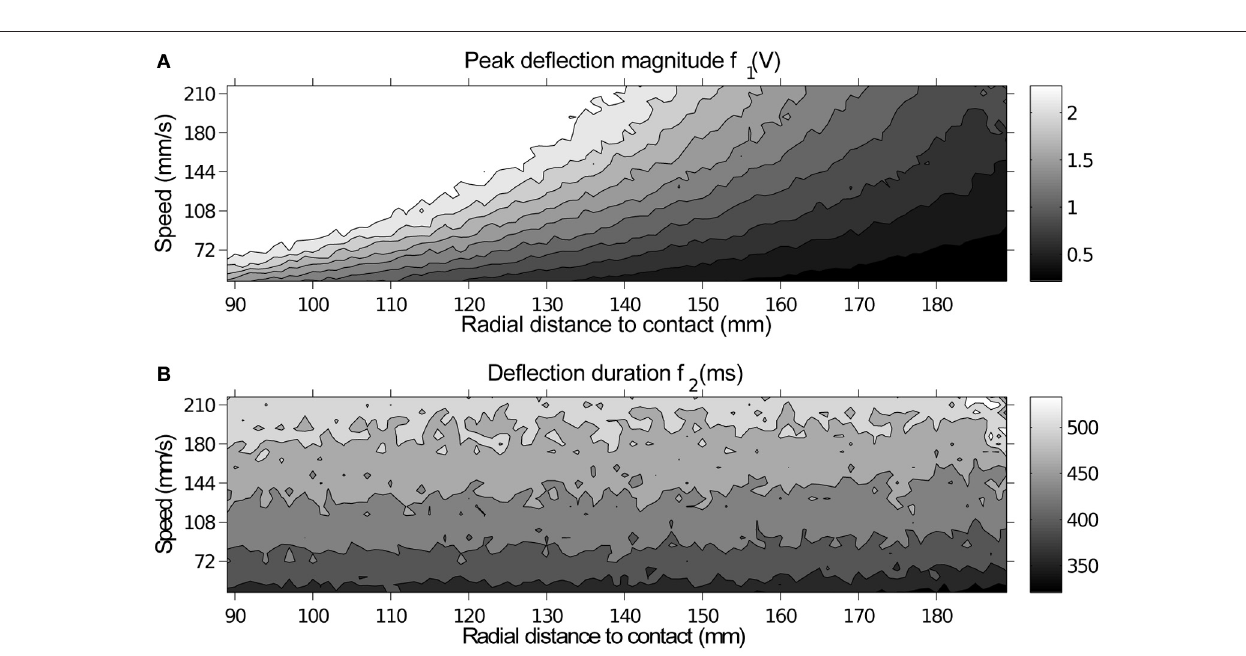
FIGURE 7 | A contour plot of peak deflection magnitude and duration for each contact showing how each feature varies with respect to contact parameters. Each point in the image corresponds to a location in the speed-radial distance space, which is equivalent in both plots. (A) Peak